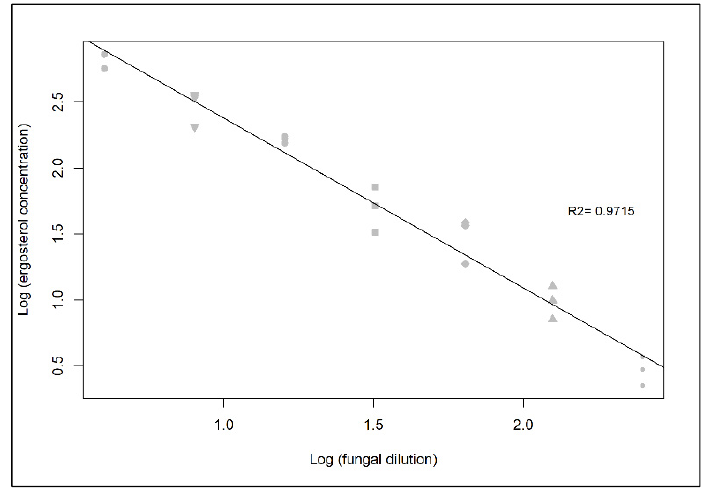
Figure 4. Relationship between ergosterol concentration and fungal biomass dilution.